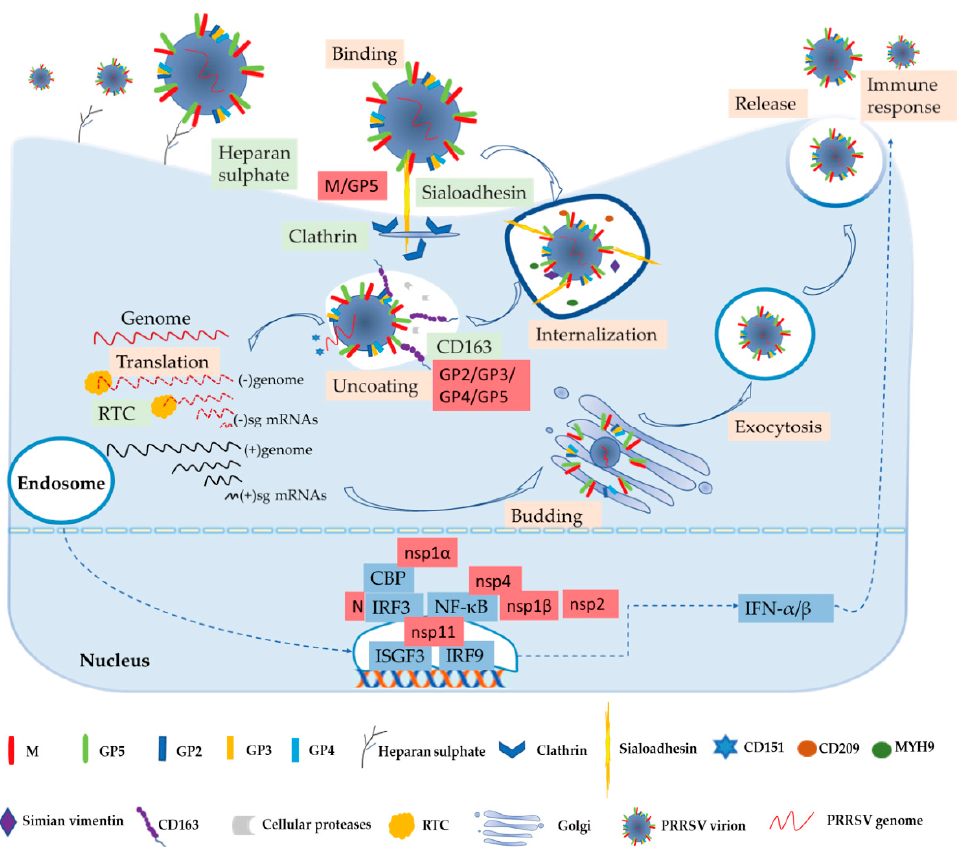
Figure 1. PRRSV replication and infection cycle, including binding, internalization, uncoating, translation, assembling, releasing the virion, and immune response. The cytokine IFN- α / β stimulates host innate and adaptive immune response against PRRSV infection first. In this process, some important viral structural and non-structural proteins interact with host factors.